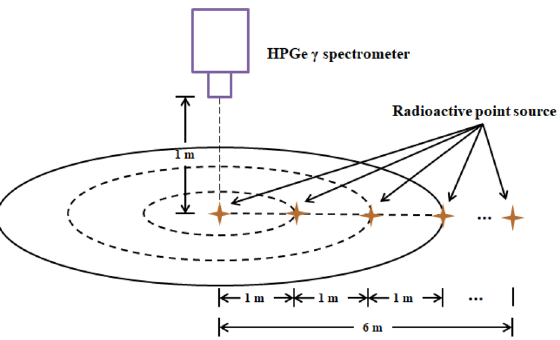
Figure 1. Schematic diagram of the detection model. The HPGe γ spectrometer was erected at a height of 1 m from the ground using a tripod, and the γ radiation source is placed at a horizontal distance of 0–6 m from the detector, and the interval is 1 m.